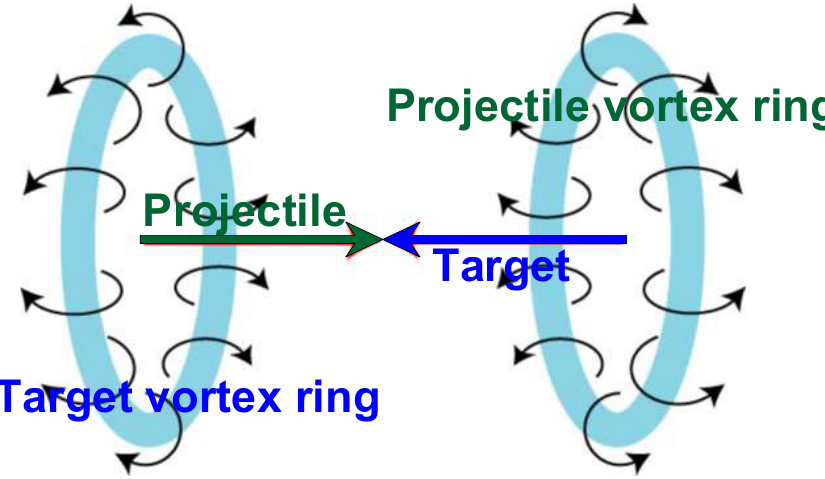
Figure 4. Schematic picture of the vortex rings at forward/backward rapidities. Curled arrows indicate the direction of the circulation of the